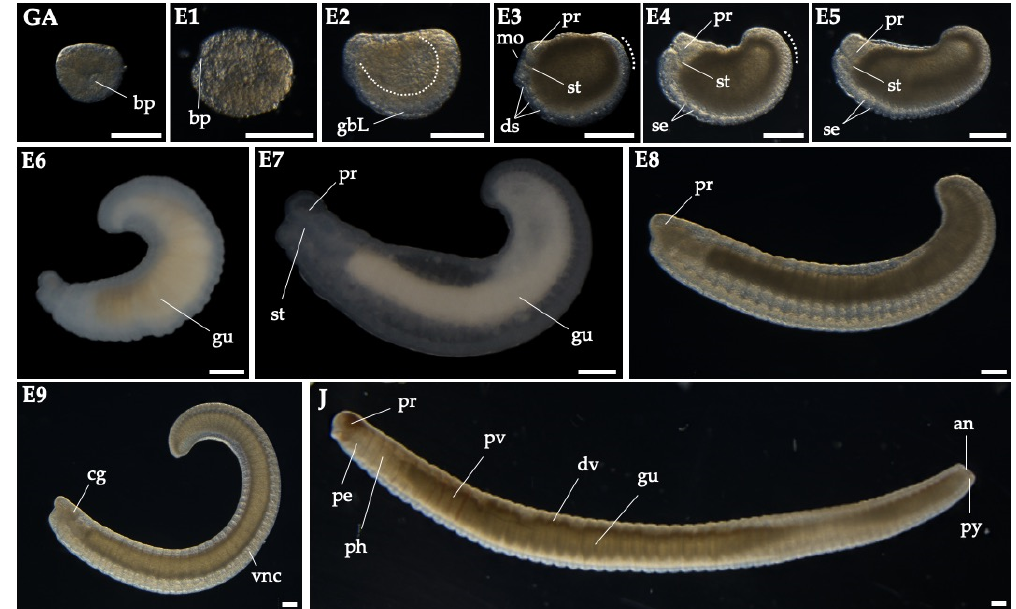
Figure 2. The embryonic development of P. excavatus was staged based on its morphology. Gastrulation (GA), the embryonic stage 1–9 (E1–9), and the juvenile stage (J). Gastrulation stage is shown in ventral view. Embryos are shown with the anterior end at the left and the dorsal side at the top. Abbreviations: an, anus; bp, blastopore; cg, cerebral ganglion; ds, dissepiment; dv, dorsal vessel; gbL, left germinal band; gu, gut; mo, mouth; pe, peristomium; ph, pharynx; pr, prostomium; pv, pumping vessel; py, pygidium; se, segment; st, stomodaeum. Scale bar, 100 μm.